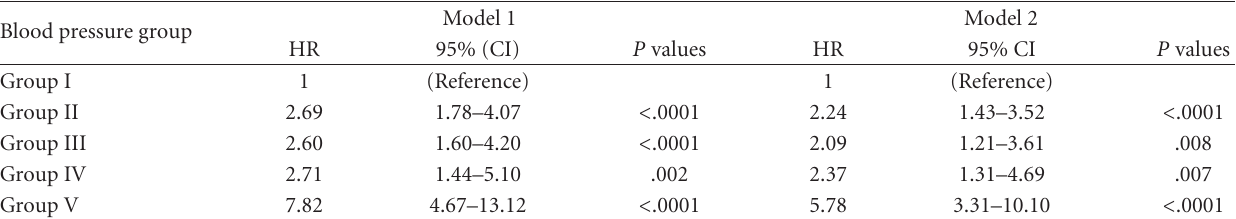
Table 2: Hazard ratios (HR, 95% Confidence Interval (CI)) of cerebrovascular events according to the specified blood pressure groups (total n = 3808, no of events =